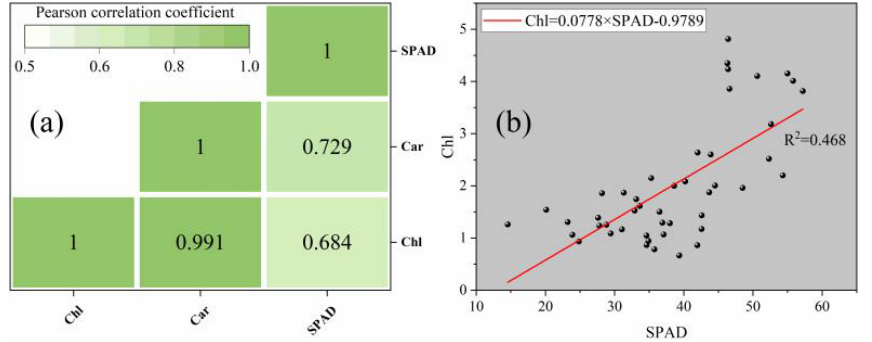
Figure 17. Relationship between measured SPAD value and PPC. ( a ) R diagram between SPAD, Chl and Car in 46 measured data. ( b ) Linear scatter plot of SPAD and Chl.